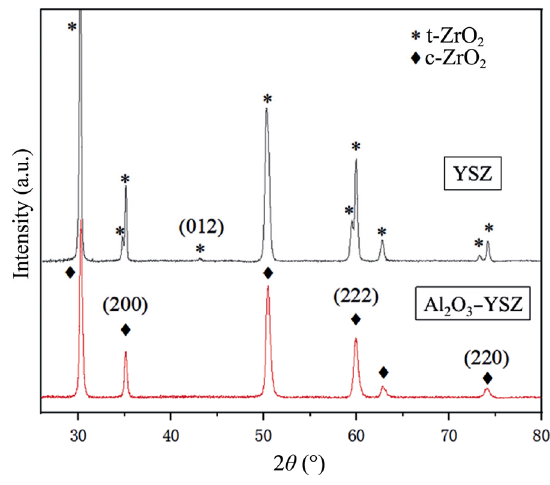
Fig. 1 XRD patterns of the as-sprayed YSZ and Al 2 O 3 –YSZ coatings.